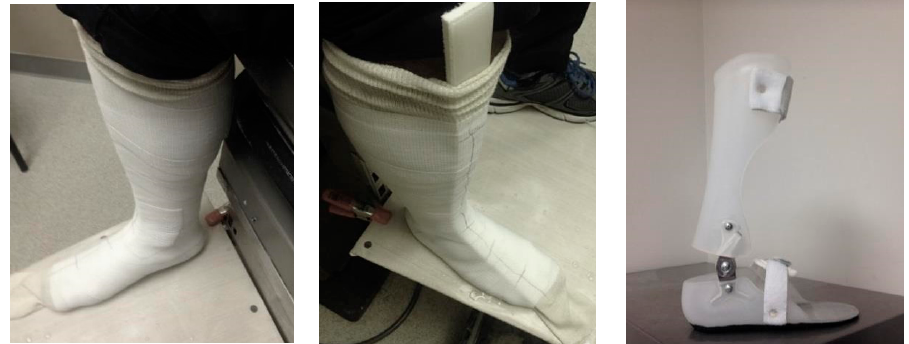
Figure 3. Patient-specific Ankle Foot Orthosis (AFO) casting.